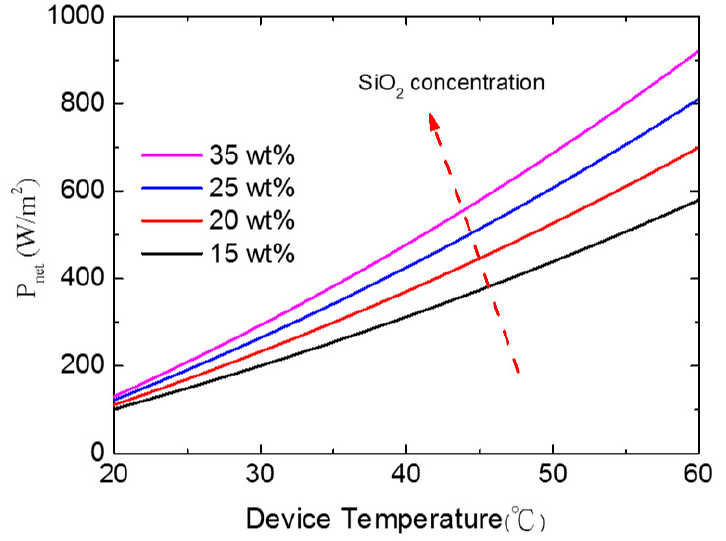
Figure 5. Theoretical net cooling power of the SiO 2 –PMMA nanocomposite film as a function of the radiative cooling device temperature. The ambient temperature is assumed to be 27 °C.